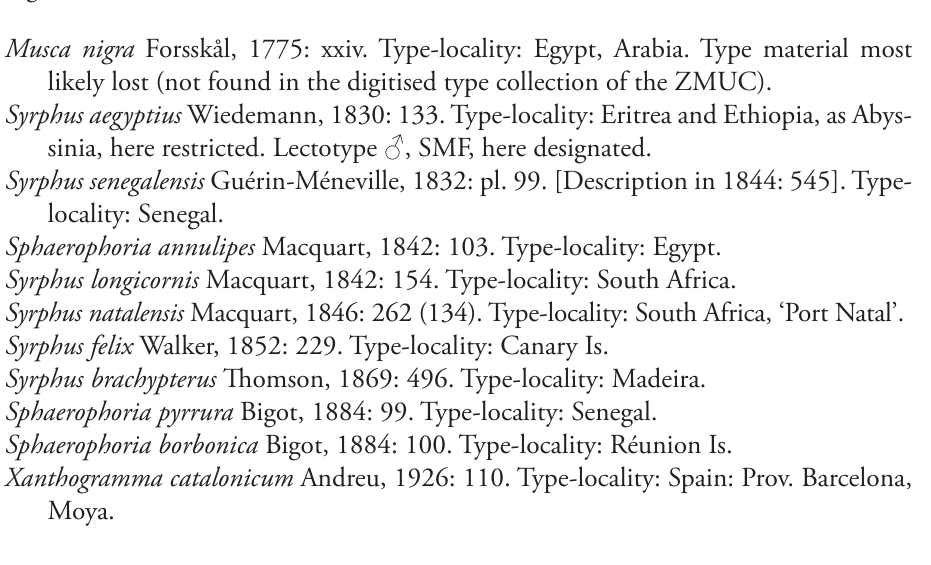
likely lost (not found in the digitised type collection of the